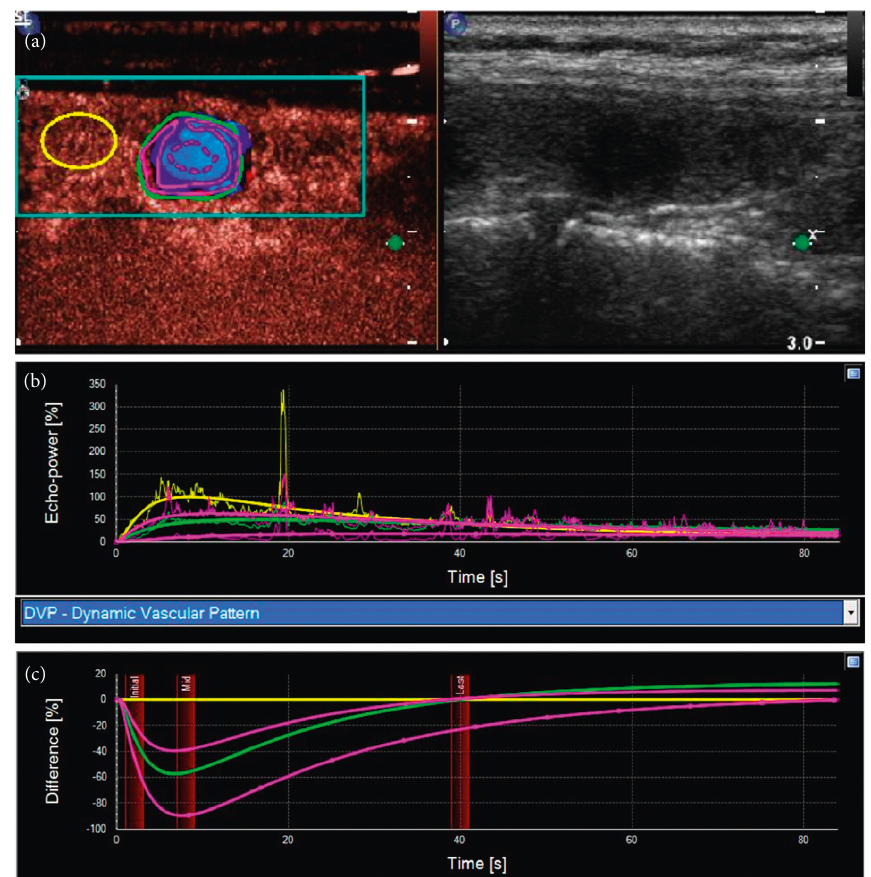
Figure 1: (a) SonoLiver software was used to analyze the dynamic contrast video. A series of regions of interest were demarcated. (b) Time- intensity curve. (c) Time-difference curve. Table 1: Basic information of each group and basic characteristics of nodules.